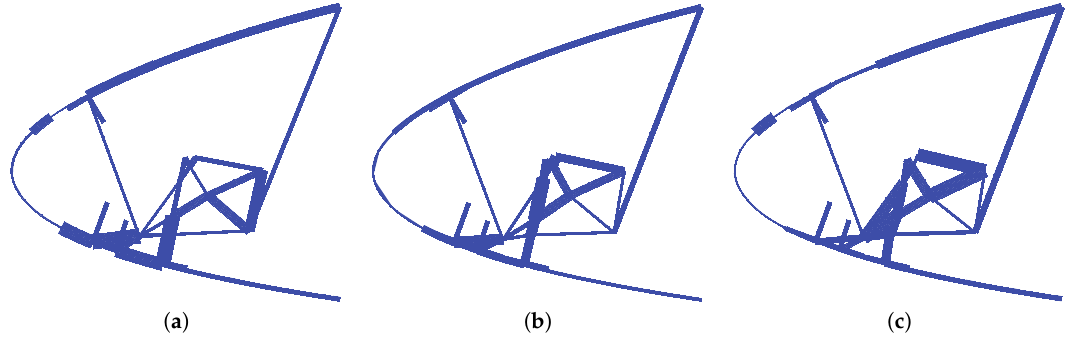
Figure 18. Solution comparison: initial solution ( a ), optimal aluminum solution ( b ), and optimal NiTiNOL solution ( c